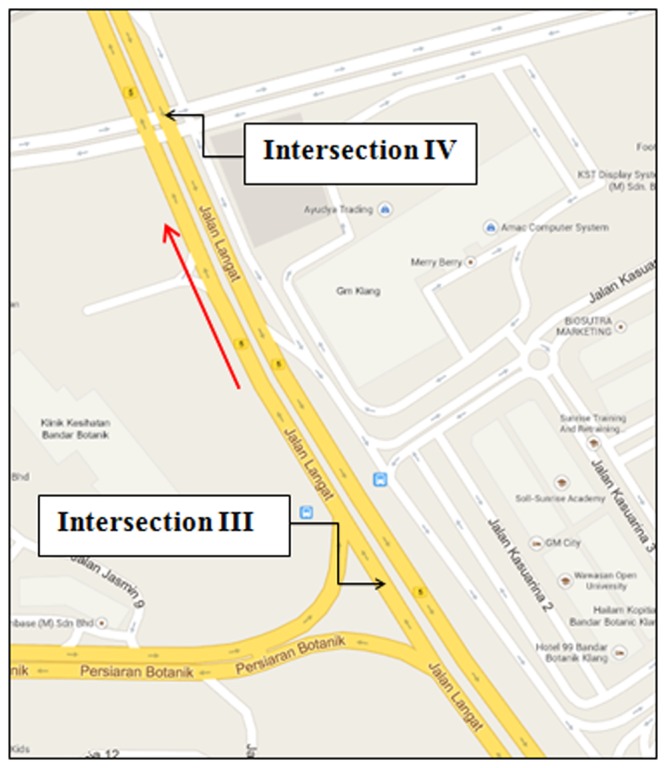
Fixed-time traffic systems at Jalan Langat.